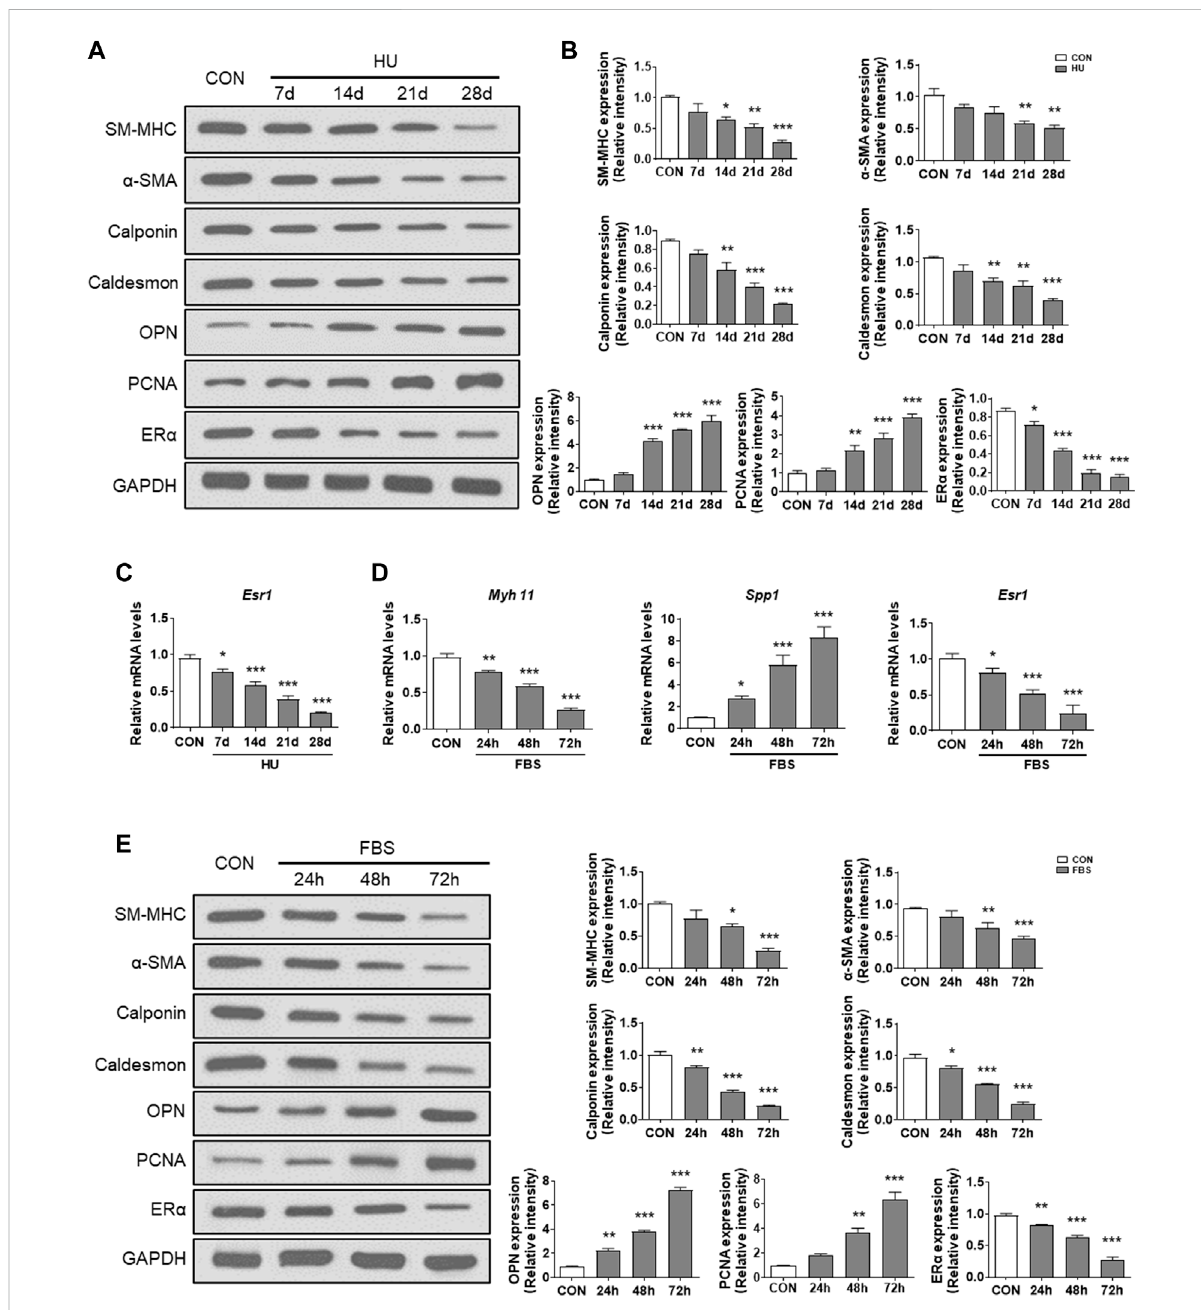
FIGURE 1 ER α is associated with phenotype switching of VSMCs in vitro and in vivo . (A,B) Western blot analysis of SM-MHC, α -SMA, calponin, caldesmon, OPN, PCNA and ER α protein levels in rat cerebrovascular VSMCs under HU or control (A) , and quanti fi cation of the protein levels compared to GAPDH (B) . (C,D) , Western blot analysis of SM-MHC, α -SMA, calponin, caldesmon, OPN, PCNA and ER α protein levels in A7r5 cells treated with FBS (C) ,andquanti fi cationoftheproteinlevelscomparedtoGAPDH (D) . (E) ThemRNAexpressionlevelsof Esr1 inratcerebrovascularVSMCsunder HU or control. (F) The mRNA expression levels of Myh11 , Spp1 , Esr1 in A7r5 cells treated with FBS for different hours. CON, control; HU, hindlimb unweighting; Values are the mean ± SEM ( n = 6 mice or 3 independent cell isolations per group). * p < 0.05, ** p < 0.01 and *** p < 0.001 vs.